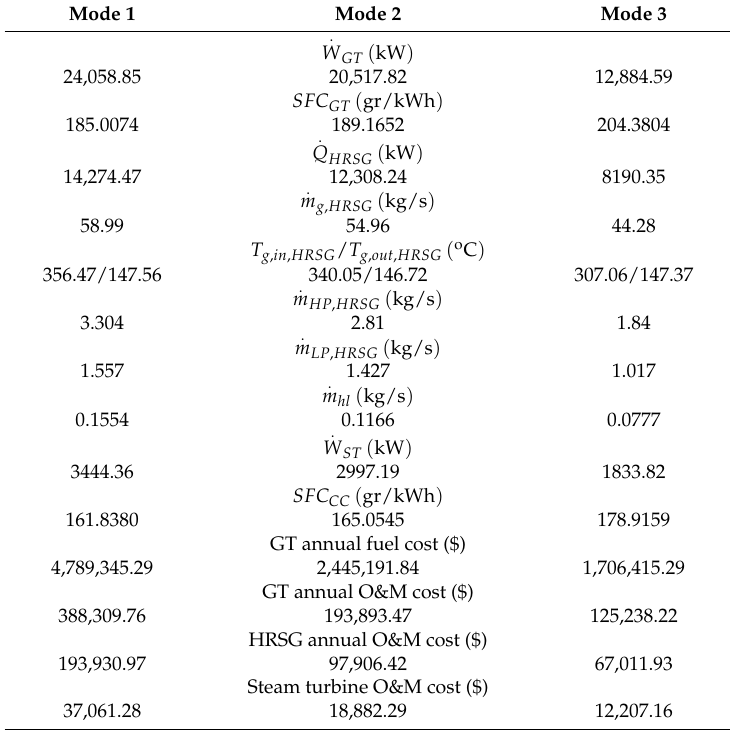
Table 9. Operational technical and economic characteristics for the system with gas turbine type (c) and fuel MDO.